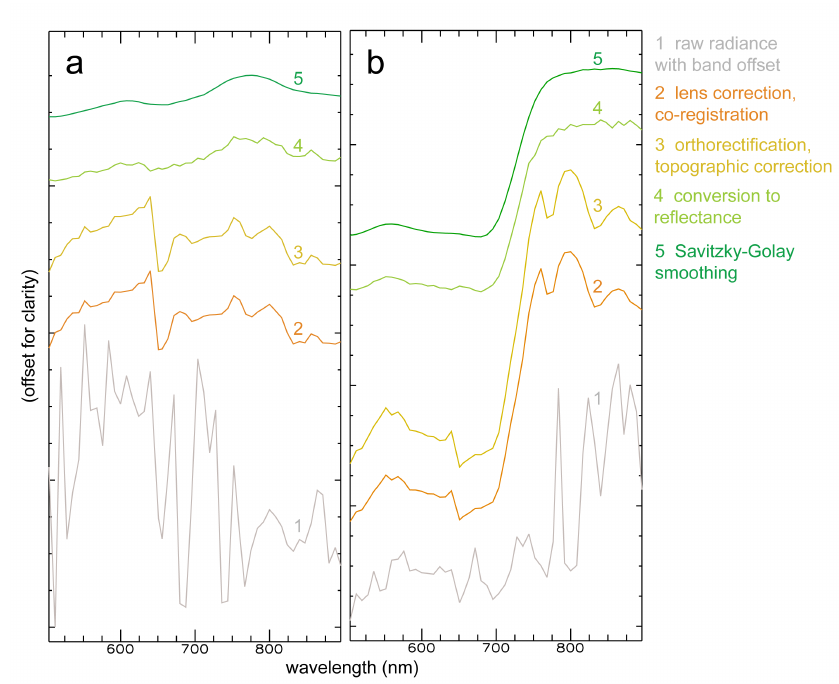
Figure 7. Comparison of spectra of image pixel after several correction steps: ( a ) iron-rich gossanous rock; ( b ) pine tree.